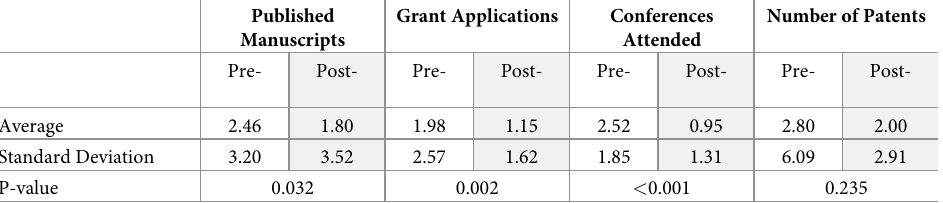
Table 2. Participant reported average number of manuscripts, grant applications, conferences attended and pat- ents pre- and post- COVID-19.